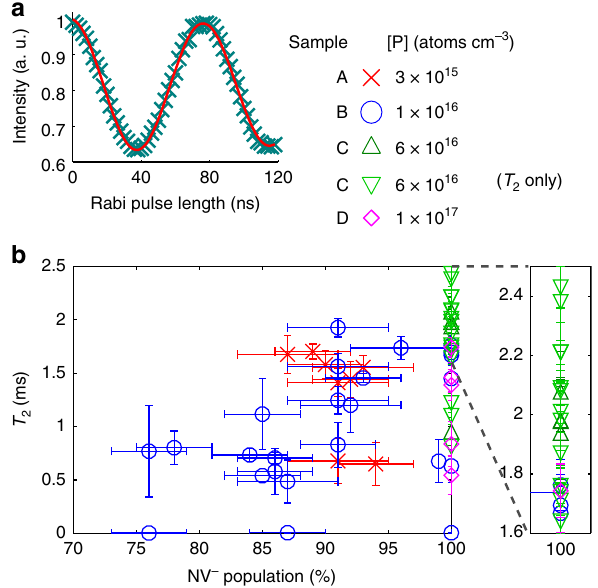
Fig. 1 Measuring nitrogen vacancy (NV) centres in phosphorus-doped diamond. a Result of Rabi measurement (data with blue crosses, sinusoidal − population for four samples fi t with red line, 37% contrast). b T 2 vs NV A – D with different doping levels: 3 × 10 15 (red, crosses), 1 × 10 16 (blue, circles), 6 × 10 16 (green, up-pointing triangles have veri fi ed NV − population, down-pointing triangles were added to show more statistics for T 17 atoms cm − 3 2 only, but do likely have the same population), and 1 × 10 (magenta, diamonds). The error bars indicate standard errors. The top right of the graph is